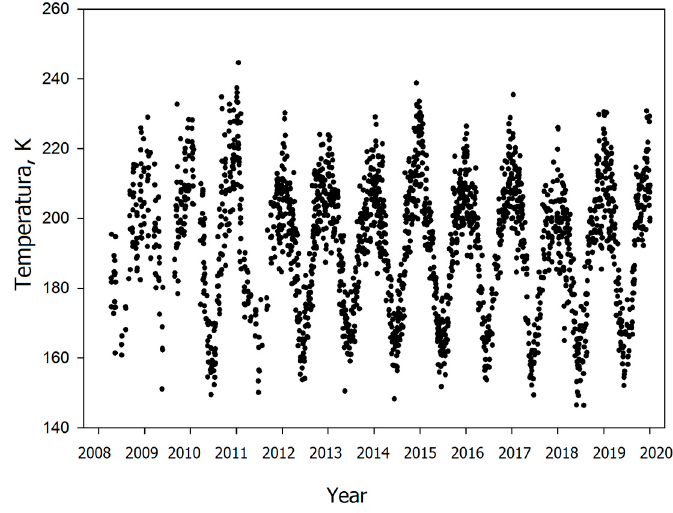
Figure 1. Nightly average values of the OH rotational temperature under analysis (2185 values). Labels indicate the beginning of the year.